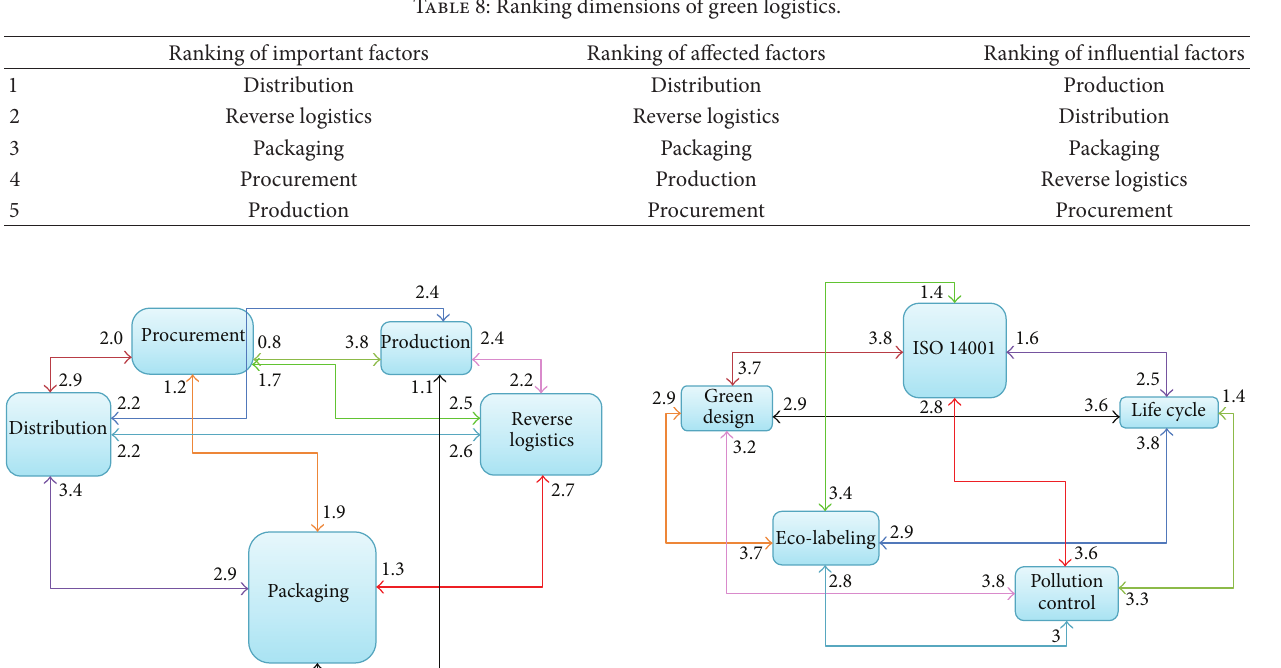
Figure 5: Graphical initial direct impact relation inside environ- mental protection.